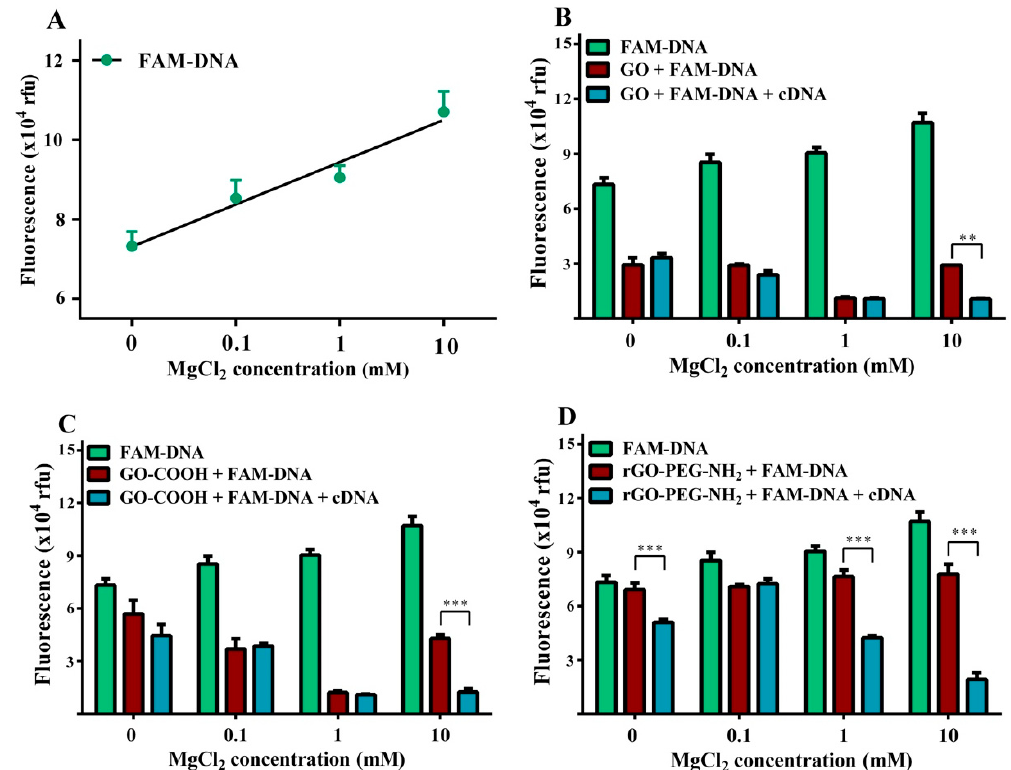
Figure 6. Representation of fluorescence values in the presence of 0.1 mM, 1mM and 10 mM MgCl 2 for ( A ) 100 nM FAM DNA, coefficient of determination R 2 = 0.903, p < 0.0001. ( B ). Graphene oxide, ( C ) carboxyl graphene oxide, ( D ) reduced graphene oxide amino-PEG covalently linked . Concentrations: 10 μ g/mL graphenic materials, 100 nM FAM-DNA and 100 nM complementary DNA. Values represent mean ± SD of n = 3. (** p < 0.01, *** p < 0.001).